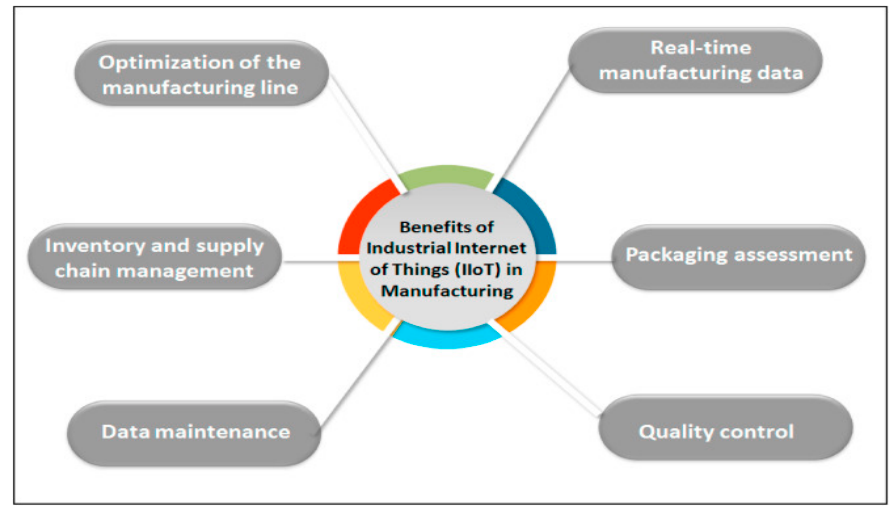
Figure 2. Applications of IoT in manufacturing [30].